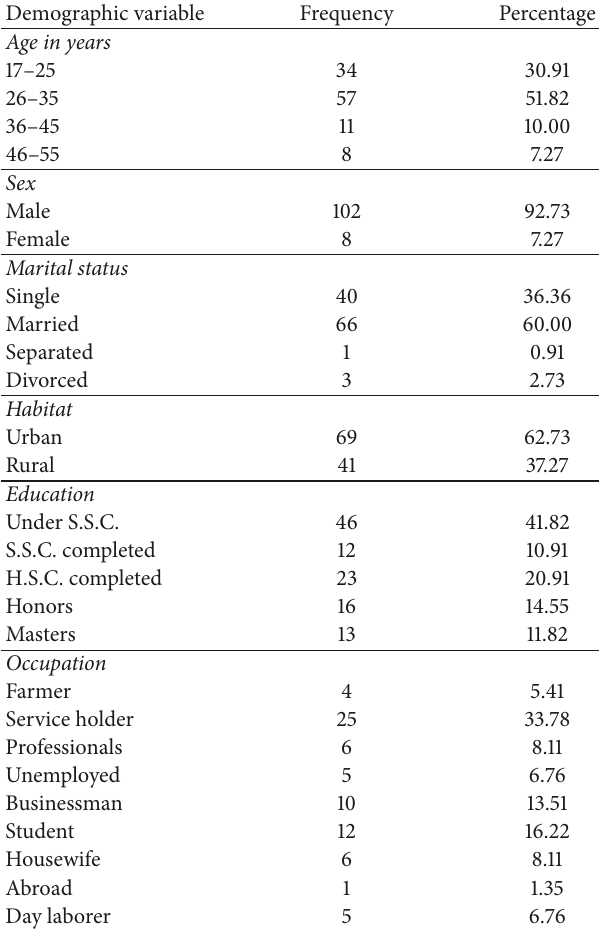
Table 1: Distribution of demographic variables of the respondents ( 𝑛 = 110